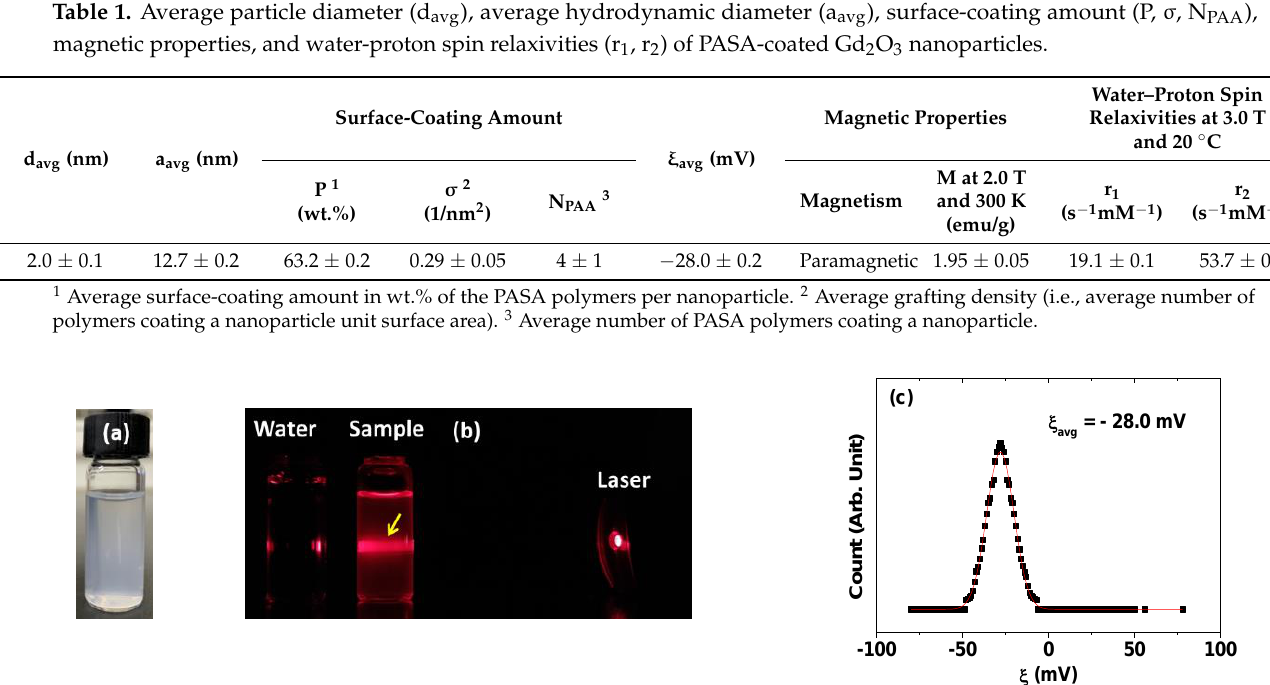
Water–Proton Spin Magnetic Properties Relaxivities at 3.0 T